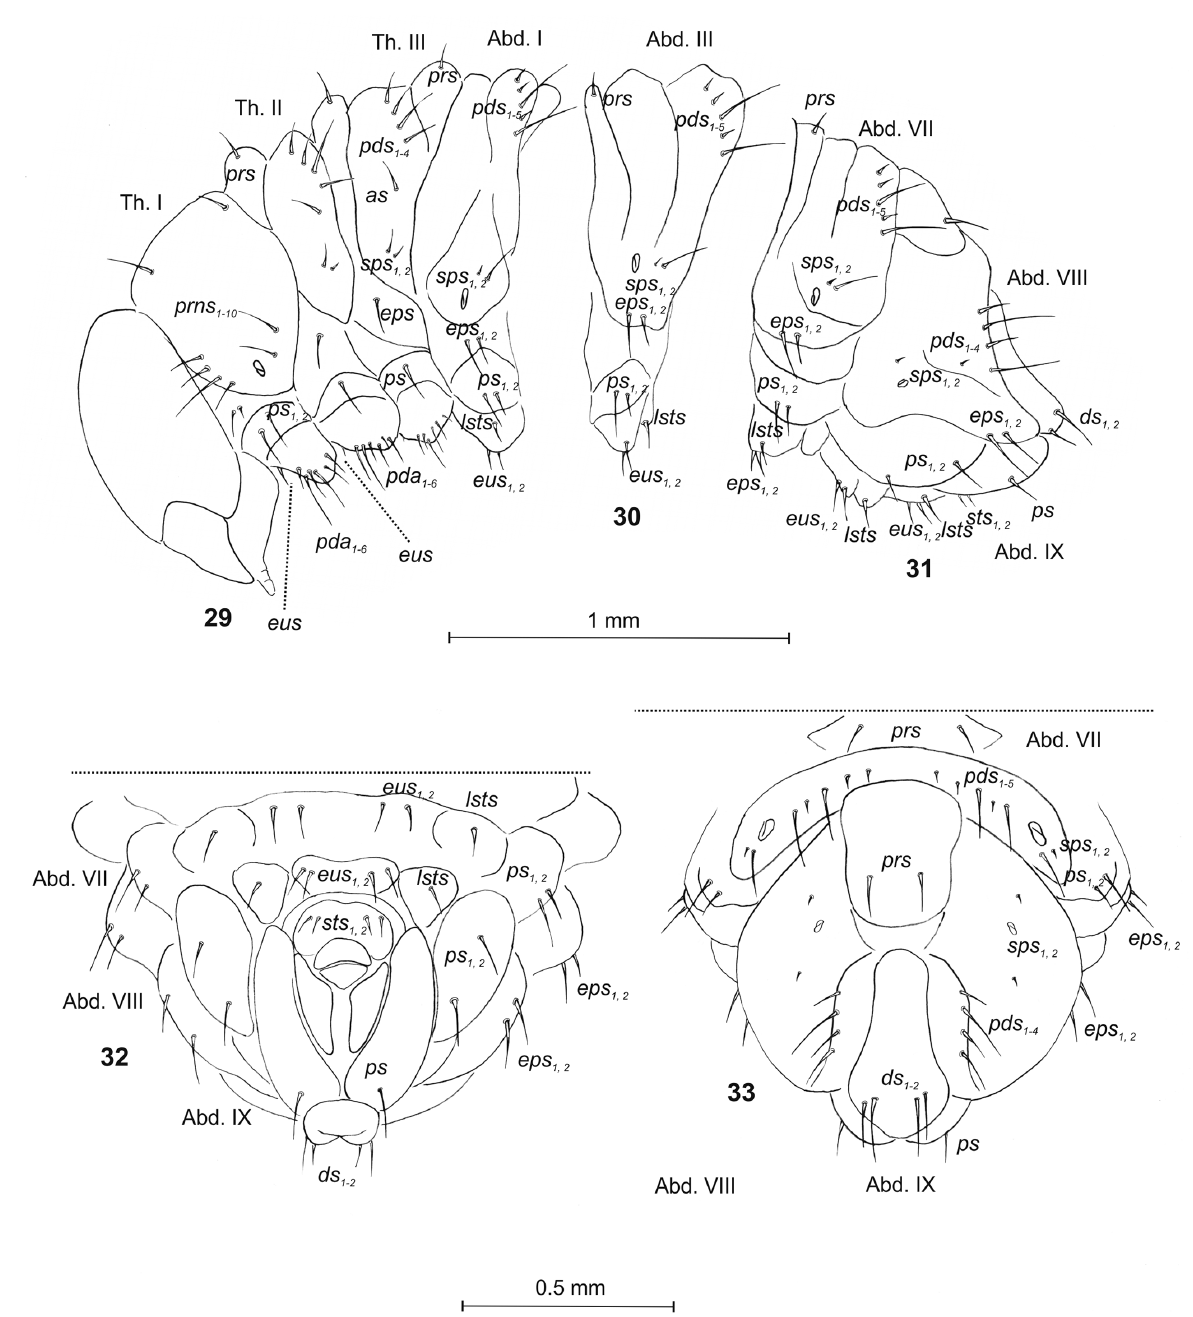
dark yellow. Setae medium long to very short. Each side of prothorax (Fig. 29) with 10 prns , two setae placed below spiracle. Meso- and metathorax (Fig. 29)